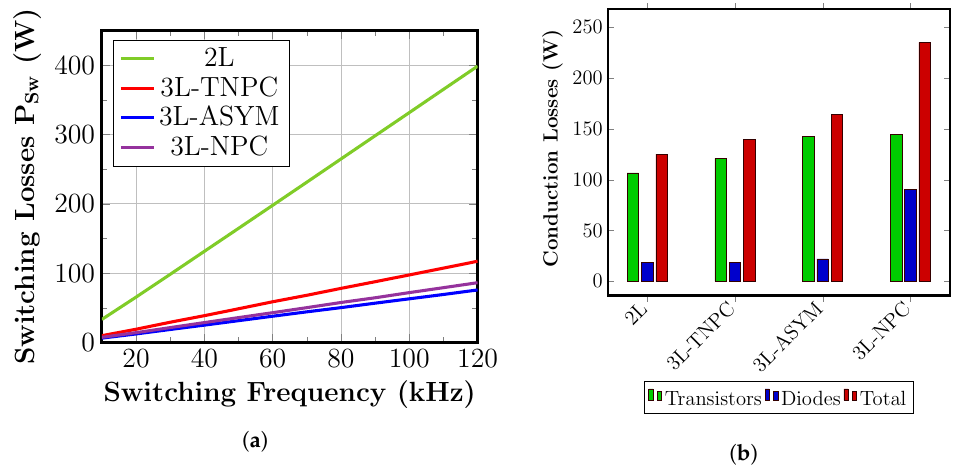
Figure 19. ( a ) Switching losses vs the switching frequency for the 2L and the 3L topologies. ( b ) Conduction losses for the 2L and 3L at 100% compensating